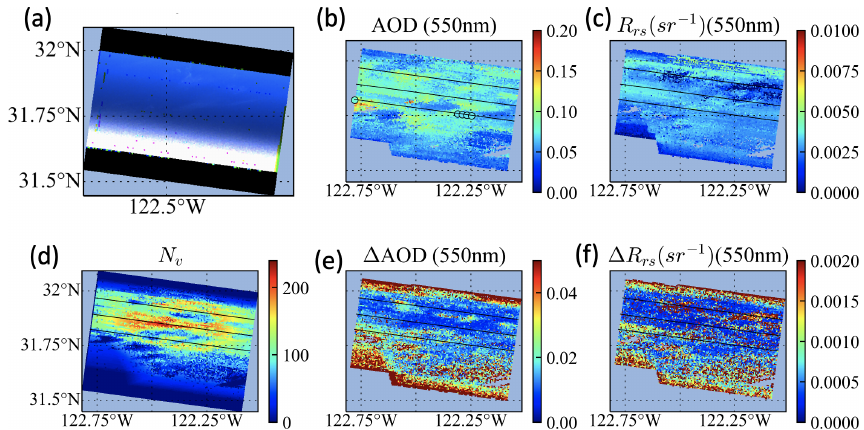
Figure 10. (a) RGB image for Scene 2 on 23 October 2017. Retrieval results are shown for (b) AOD and (c) R rs , respectively; retrieval uncertainties for these are shown in panels (e) and (f) , respectively. (d) The number of total observations used in retrievals. The HSRL AODs at 532nm are indicated in panel (b) . More detailed analysis on AOD and its uncertainties over the three solid lines are discussed in Fig.